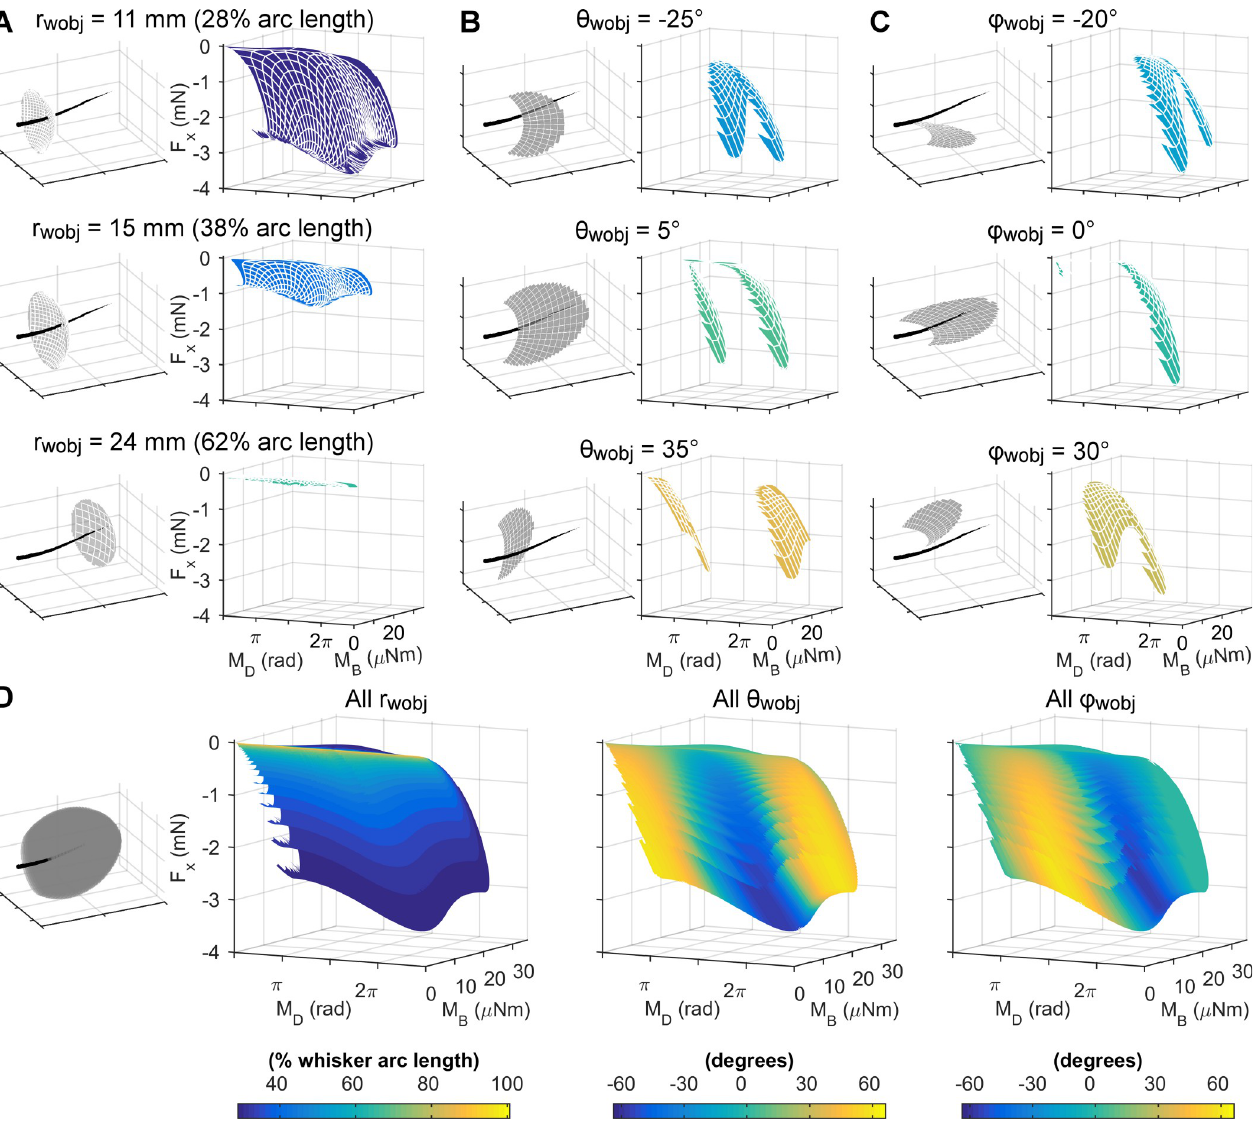
Fig 3. The mappings between mechanical variables and the 3D whisker-object contact point can be represented as solids, each drawn as series of monochromatic surfaces. The left columns of panels A , B , and C depict the whisker in black, with all reachable contact points shown as gray surfaces for the indicated radial distance (r wobj ), azimuthal angle ( θ wobj ), or elevation angle ( φ wobj ). The right columns of panels A , B , and C plot the monochromatic surfaces that correspond to the F x , M B , and M D signals for the indicated radial distances and angles. The colormaps for panels in A , B , and C are obtained from the colorbars in the corresponding columns of D . (D) The monochromatic surfaces for each of the r wobj , θ wobj , and φ wobj mappings are layered together to form three “solids.” First column : The whisker is shown in black and all reachable contact points are shown in gray. This panel contains the identical points as Fig 2B. Second , third , and fourth columns : All the monochromatic surfaces for the different values of r wobj , θ wobj , and φ wobj are plotted together in F x , M B , and M D space. The “feathered edge” apparent in the second column is an artifact of the discretization of the r wobj values.